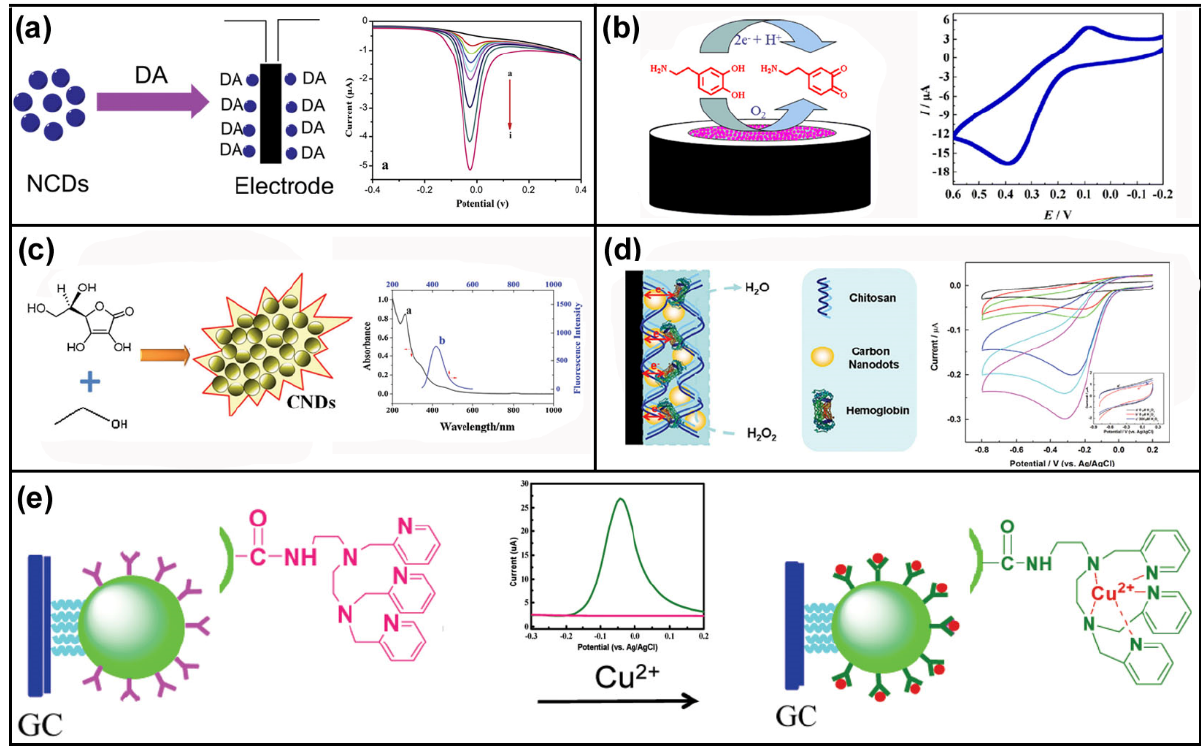
Figure 3. CD-based electrochemical sensors for food and alcoholic beverage safety. ( a ) Schematic illustration of N-doped CD synthesis and DA detection. Reprinted with permission from [67]. Cop-